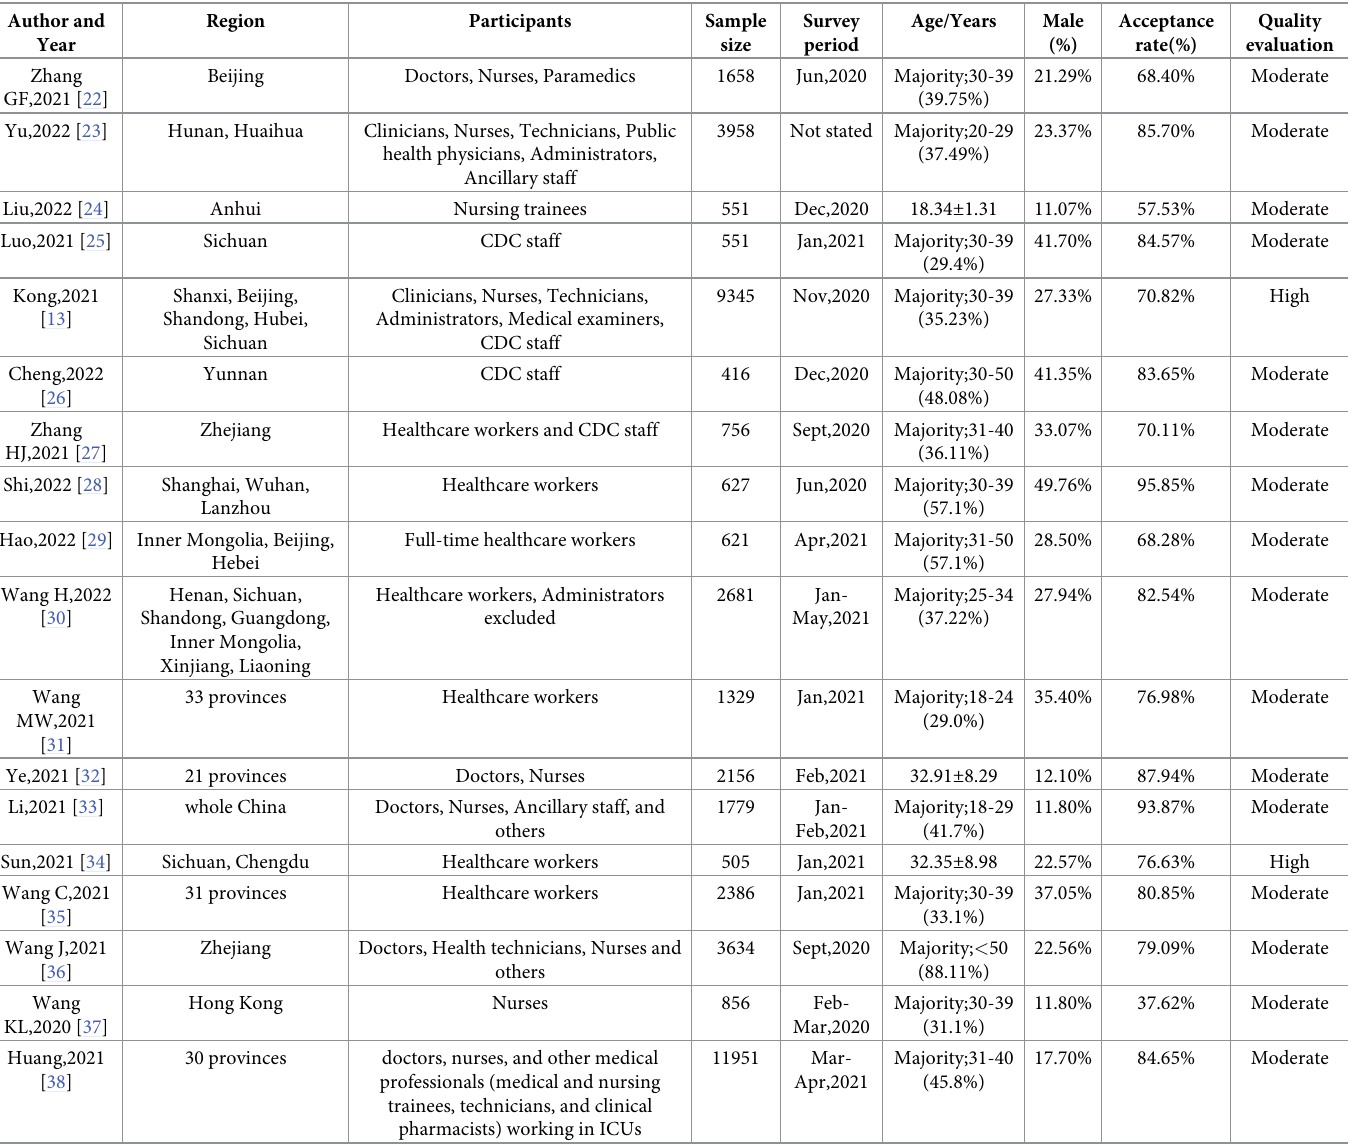
Table 1. Characteristics of the included